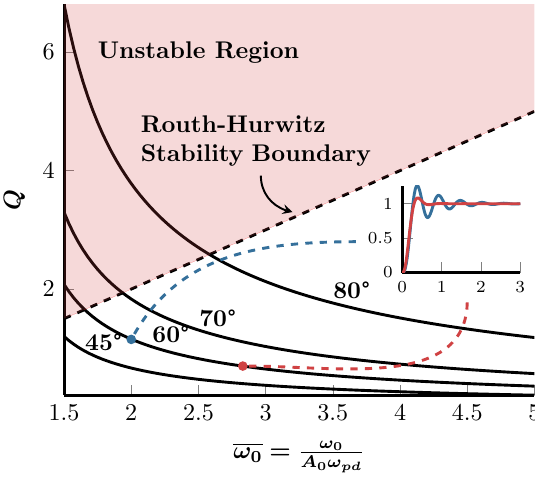
Figure 2. Phase margin contours of an all-pole three-stage OTA. The inset plot shows the unity-gain feedback step responses for two different OTAs both having a phase margin of